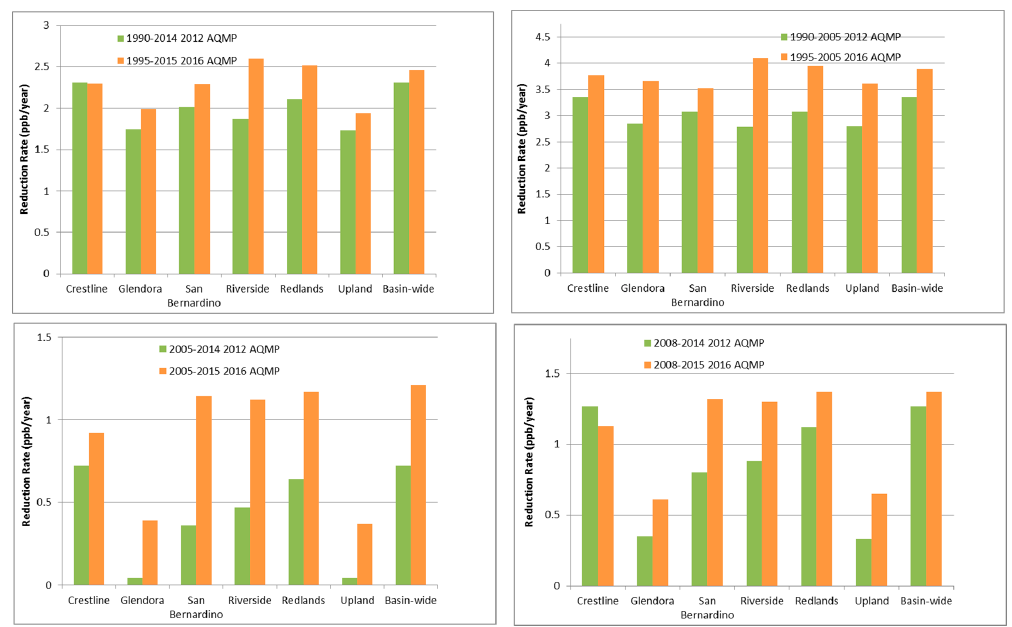
Figure 13. Comparison of 2012 AQMP and 2016 AQMP modeled reduction rates of 5-year ozone design values at selected monitors for the periods from 1990 to 2014 and 1995 to 2015 ( top left ), 1990 to 2005 and 1995 to 2005 ( top right ), 2005 to 2014 and 2005 to 2015 ( bottom left ), and 2008 to 2014 and 2008 to 2015 ( bottom right ).